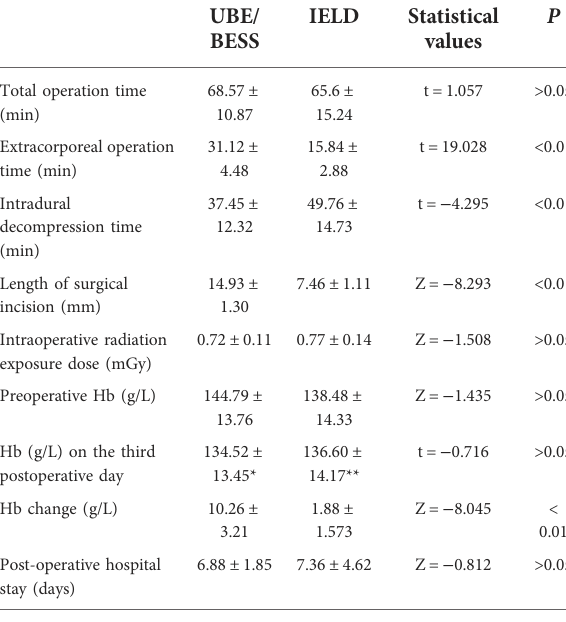
TABLE 2 Comparison of perioperative date of UBE/BESS and IELD.